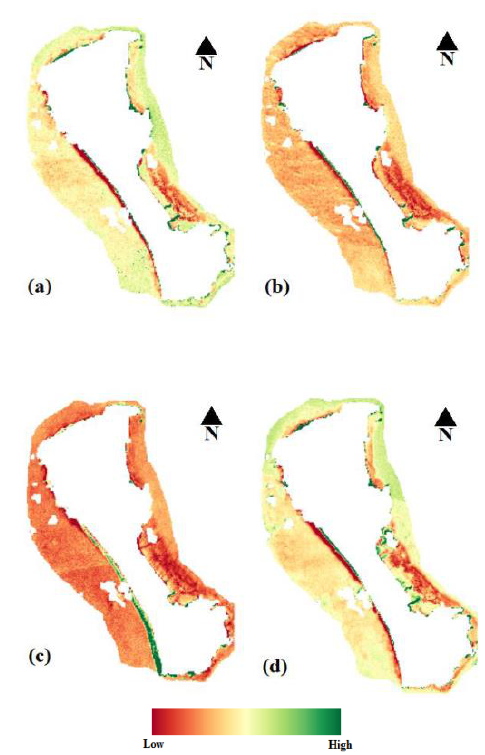
Figure 13: Processed Normalized Difference Vegetation Index (NDVI) on the inner coast of Boracay Island for (a) April (b) May (c) July (d)